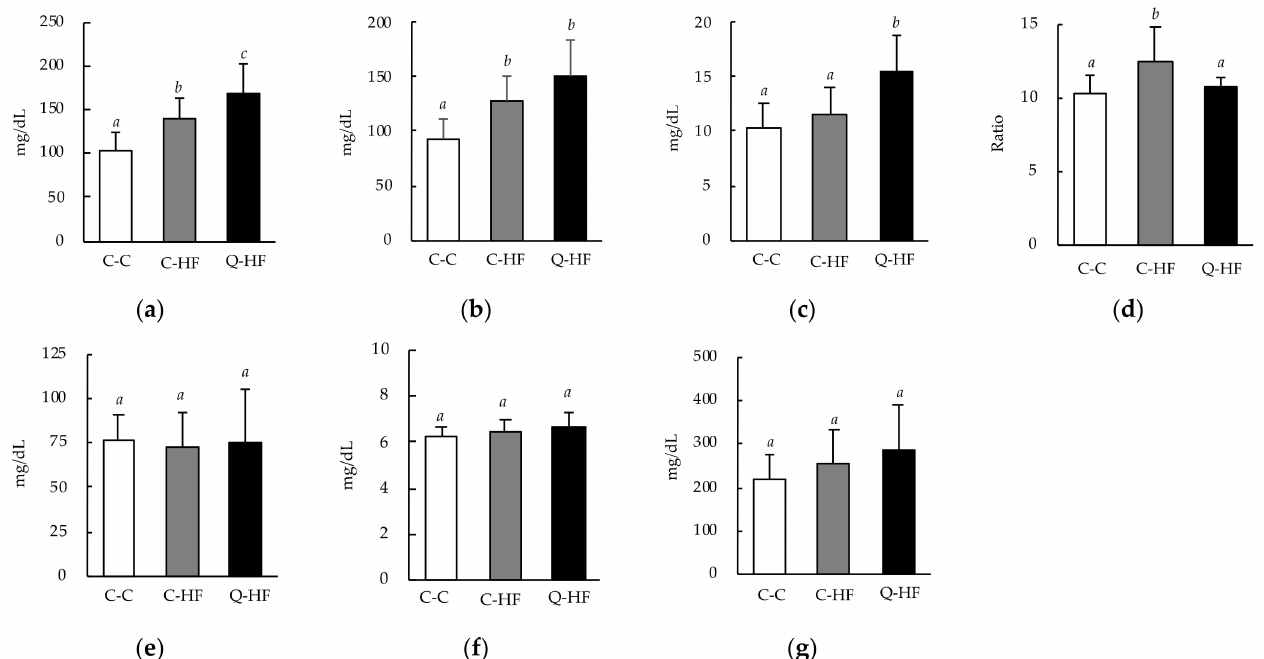
Figure 4. Effects of maternal quercetin consumption on blood biochemical parameters. Male progeny of dams fed a control diet (C) or a diet containing 1.0% quercetin (Q) were divided into three groups: progeny of dams fed the C-diet that were also fed the C-diet (C-C), progeny of dams fed the C-diet that were fed a 30% high-fat (HF) diet (C-HF), and progeny of dams fed Q-diet that were fed a HF-diet (Q-HF). The animals were permitted free access to deionized water and the C-diet or HF-diet for 13 weeks. Data are shown as the mean ± SD ( n = 10). Two-way ANOVA analysis were performed, and Fisher’s PLSD post hoc test was applied if ANOVA p values were less than 0.05. Different superscripts ( a , b , c ) indicate significant differences ( p < 0.05). ( a ) Total cholesterol. ( b ) non–HDL-cholesterol. ( c ) HDL-cholesterol. ( d ) Total cholesterol/HDL-cholesterol ratio. ( e ) Triglycerides. ( f ) Total protein. ( g ) Glucose.